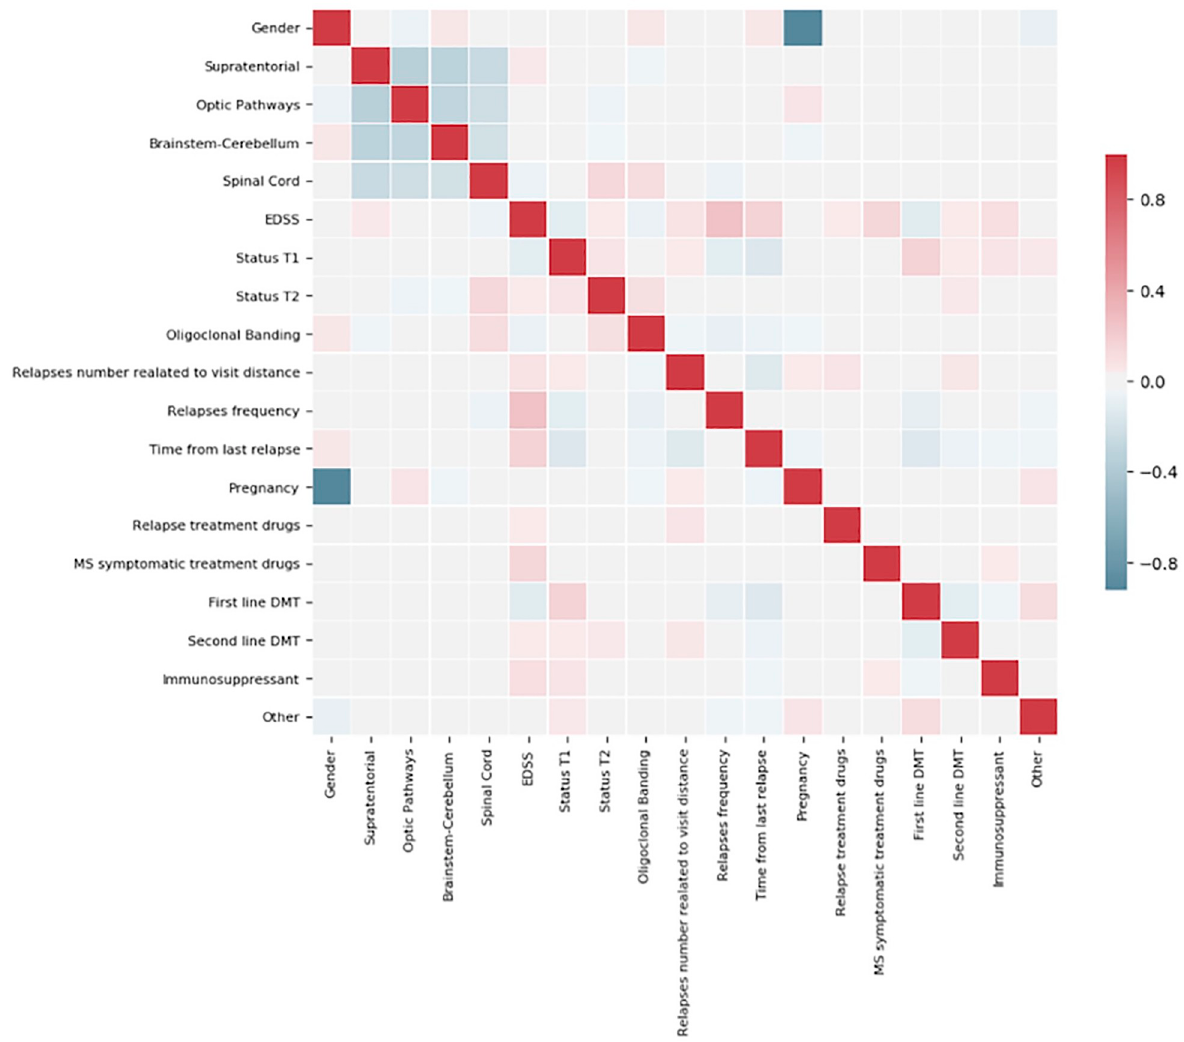
Fig 1. Pearson Matrix describing the relation among input features and the transition to the SP phase within 180 days.